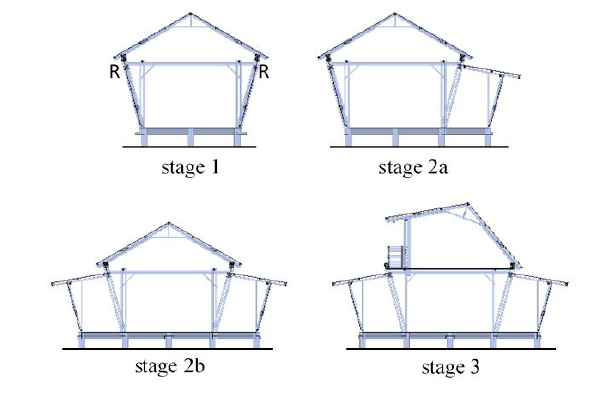
Fig. 12. T-Joint (left) and bamboo-concrete joint on the sub- structure (right) Source: Janssen